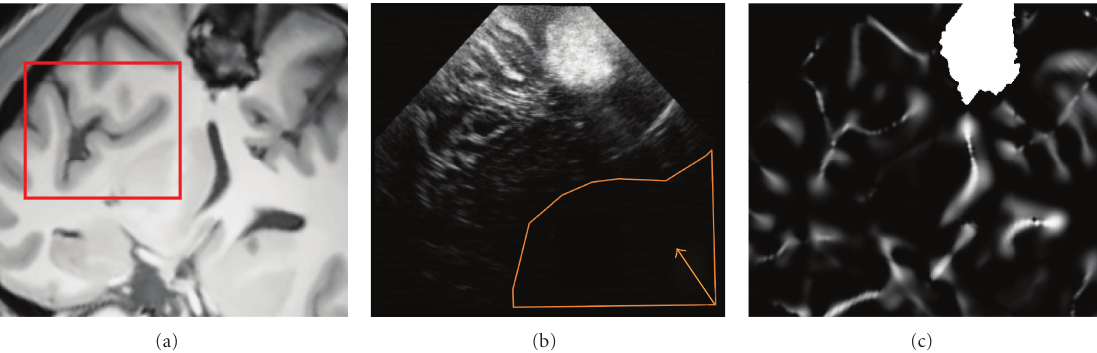
Figure 3: Patient 2. (a) The denoised MR image corresponding to US image (b). (c) The probability map based on MLvv operator and extracted from denoising MR image. The preoperative MR image is resliced with the registration matrix provided by the neuronavigation system. The matching is not perfect due to the initial error, estimated around 8 . 5mm by the experts for this patient. The red box shows a sulcal area where the matching between US image and the MLvv -based probability map is visually high. A large acoustic shadow is visible in US around the ventricle area (indicated in orange on the US image).